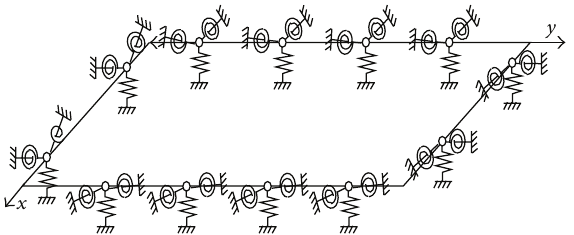
Figure 1: A Mindlin plate with general elastic boundary